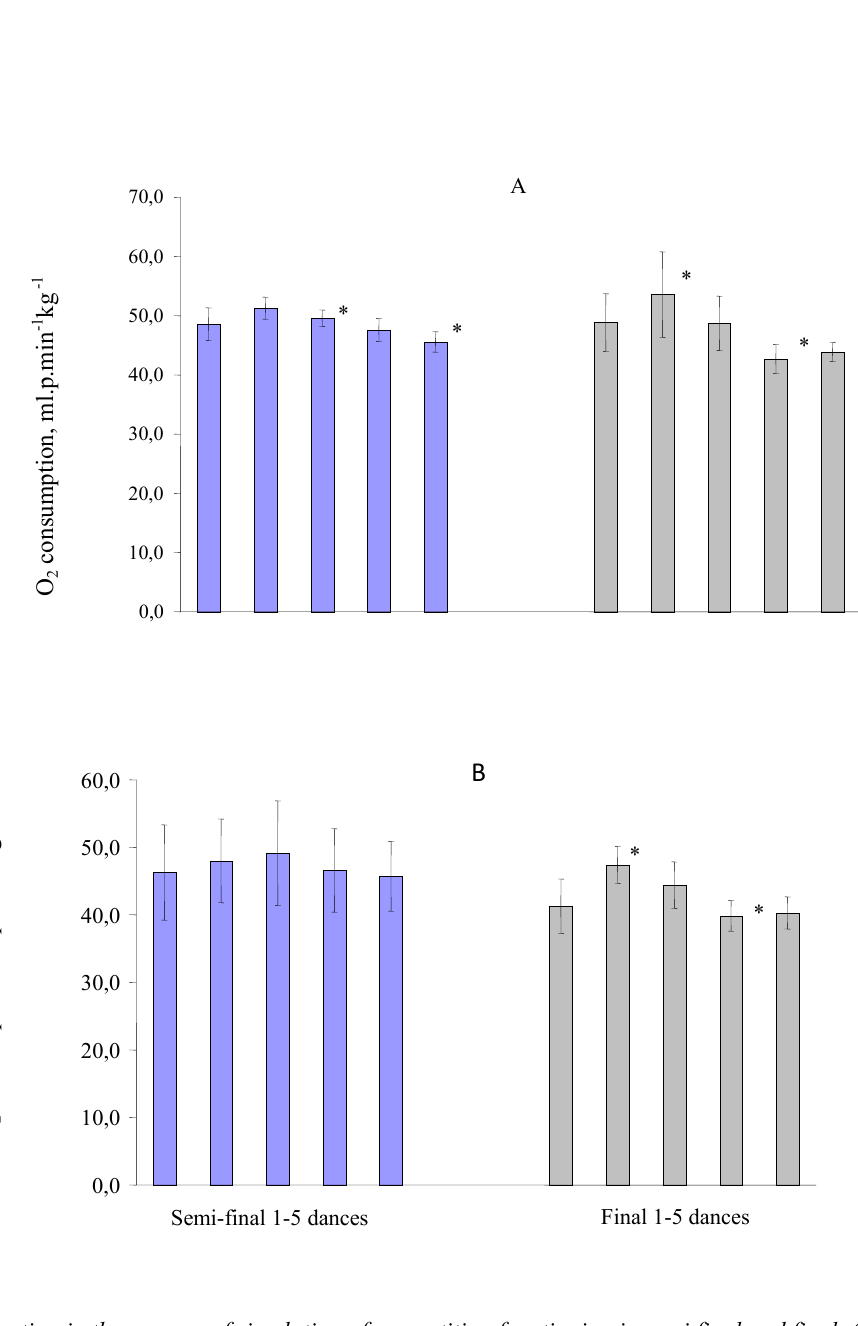
Fig.1. О 2 consumption in the process of simulation of competition functioning in semi final and final. (А) men and (B) – women * - – differences are statistically confident at